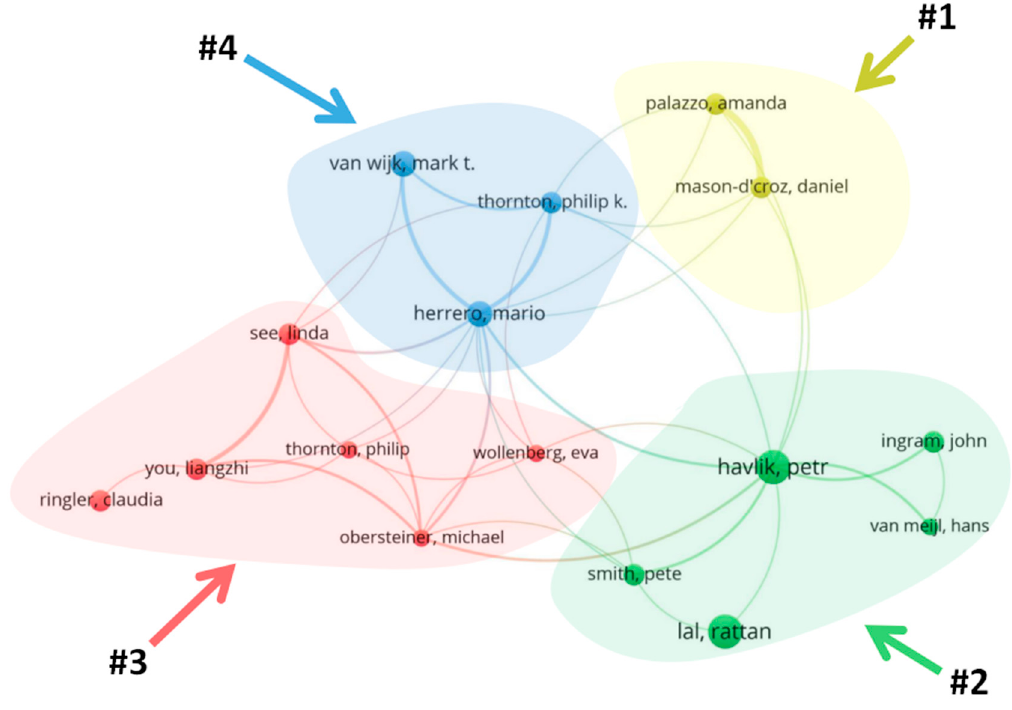
Figure 7. Author cooperation networks.